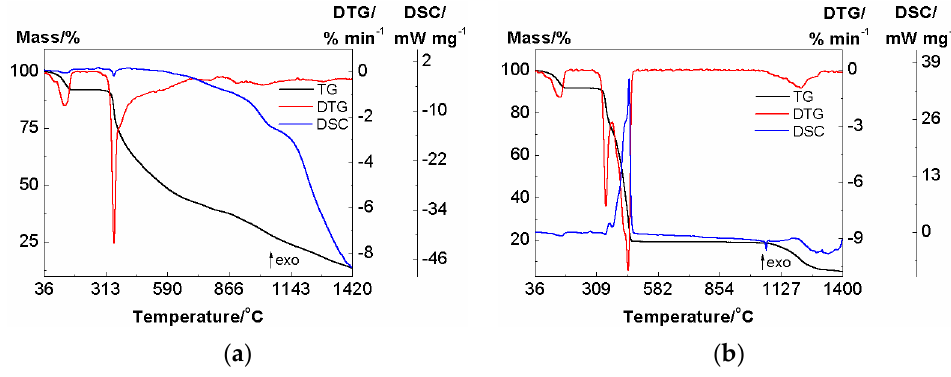
Figure 3. TG-DTG-DSC curves for complex 1: ( a ) in helium (5.06 mg), ( b ) in air (5.00 mg). Table 4. The thermogravimetric analysis data of 1 in helium and air (where: ∆ m—mass loss; t peak — peak temperature on the DSC curve; T DTG(max) —temperature at maximum mass loss on the DTG curve). Effects: ( − ) endo, (+)